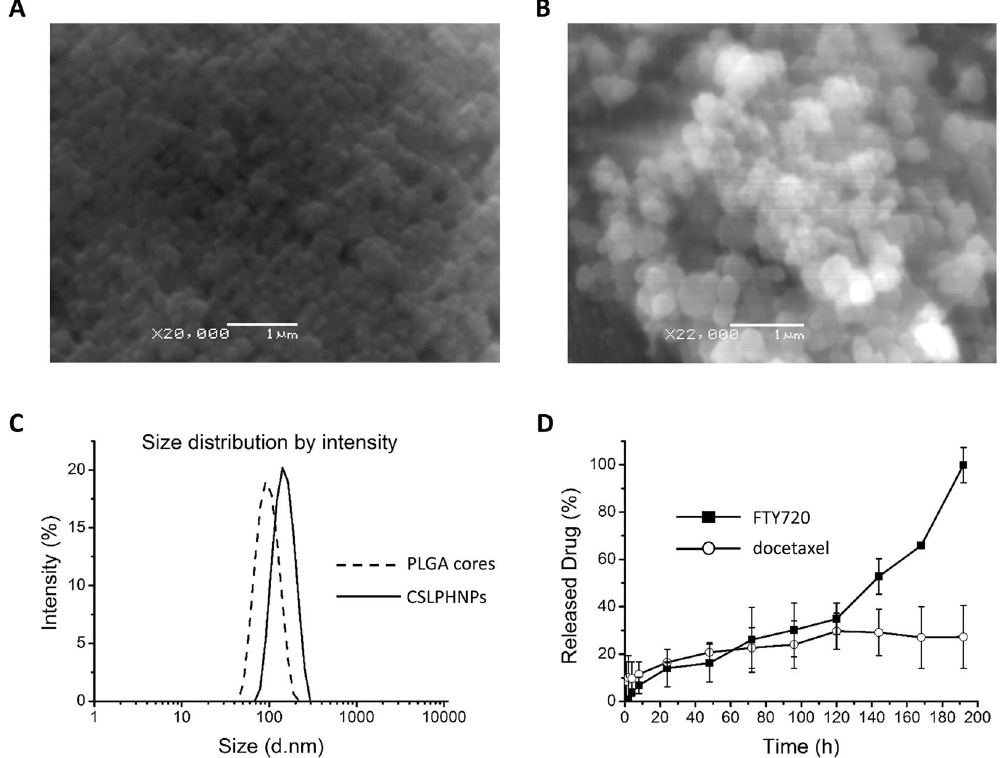
Figure 2. Characterization of CSLPHNPs. Scanning electron microscopy image of ( A ) PLGA cores and ( B ) CSLPHNPs; 20,000/22,000X magnification (Scale bar: 1 µ m). ( C ) Dynamic light scattering (DLS) measurement of the size distribution of PLGA cores-dash line, CSLPHNPs-solid line. ( D ) Temporal release of FTY720 (black squares) and docetaxel (white circles) at pH 5 was measured by liquid chromatography-tandem mass spectrometry (LC-MS/MS). Points, mean of three experiments performed in triplicate. Bars,